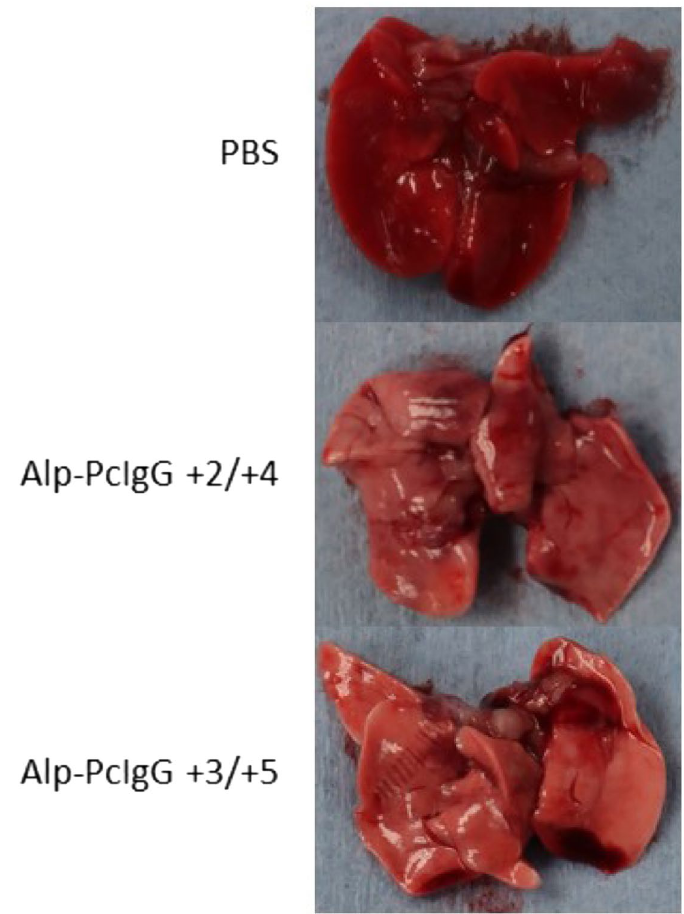
Figure 4. Gross lung pathology in Alp-PcIgG treated, ANDV infected hamsters. Syrian hamsters were infected with 154 FFU of Andes virus (ANDV) and lungs were collected upon euthanasia. Representative lung images for PBS treated hamsters as well as hamsters treated with anti-ANDV polyclonal alpaca IgG (Alp-PcIgG-ANDV) on days + 2/ + 4 and + 3/ + 5 with respect to challenge are shown. Note the diffuse deep red to plum colored appearance of the control (i.e. PBS) treated hamster lungs, indicating substantial inflammation and tissue damage. In comparison, lungs from the Alp-PcIgG treated hamsters appear a healthy pinkish color with rare areas of deeper